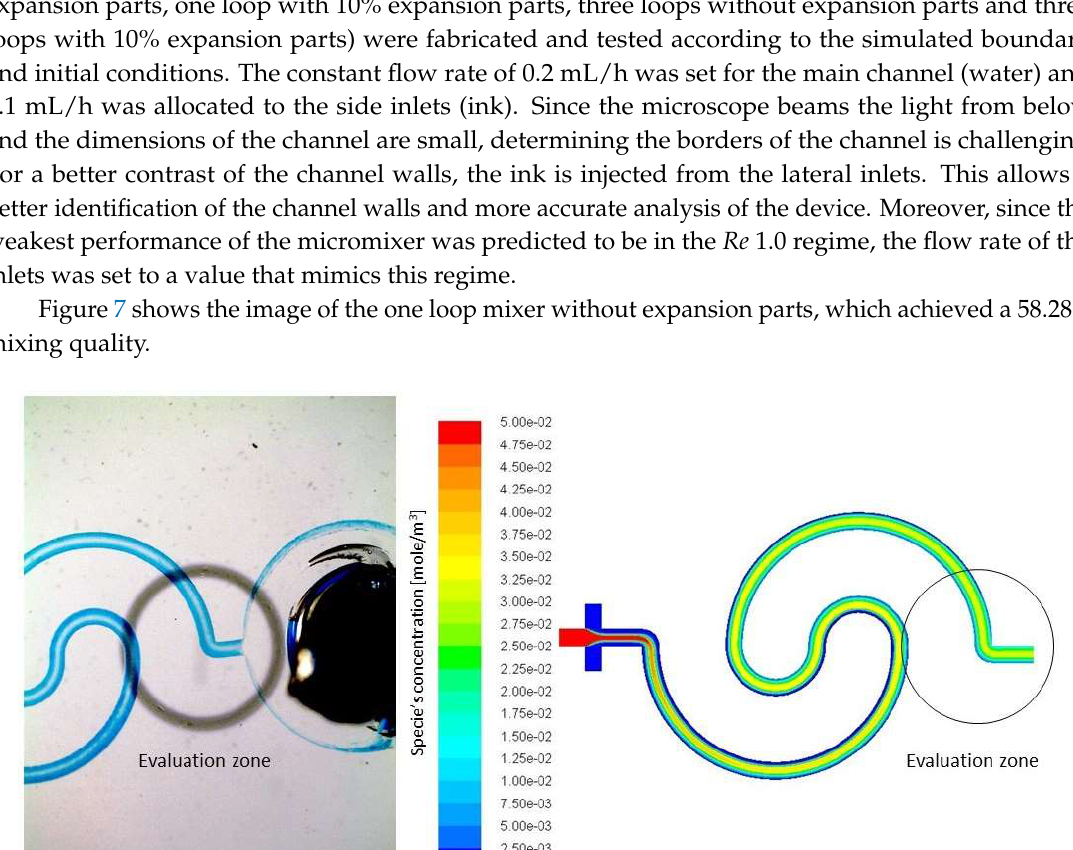
Table 7. Pressure drop amongst various types of mixers. All the values are in Pascal.